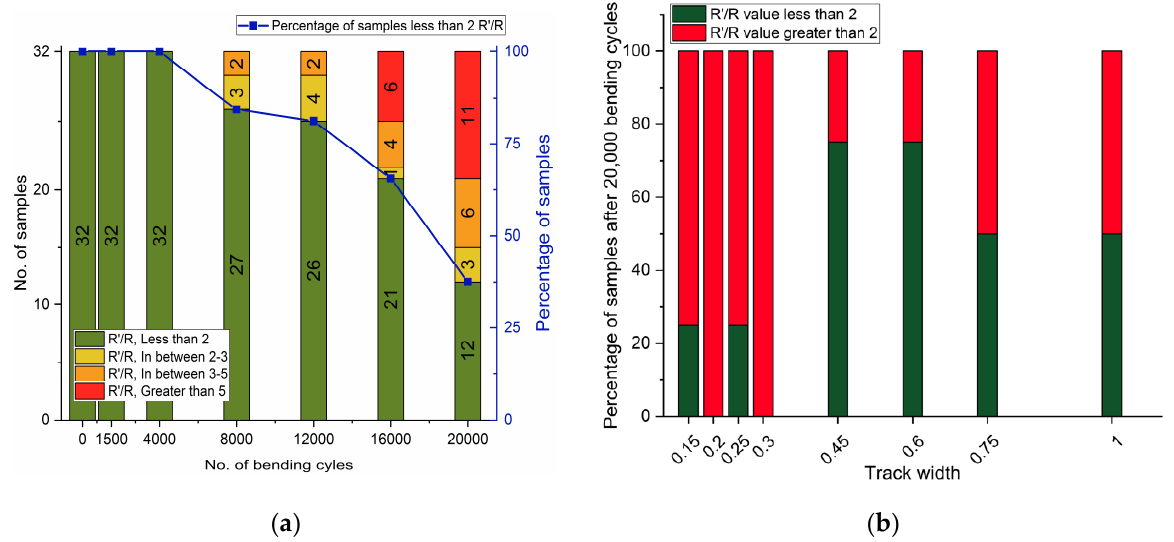
Figure 13. FPCB sample (without any protection) analyses after 20,000 bending cycles, a total of 32 samples were tested: ( a ) No. of samples with R’/R values increased above 2, 3, and 5 on the left y-axis and percentage of samples having R’/R value below 2 on the right y-axis; ( b ) ratio of samples having R’/R values below and above 2 after complete washing cycles based on track widths.